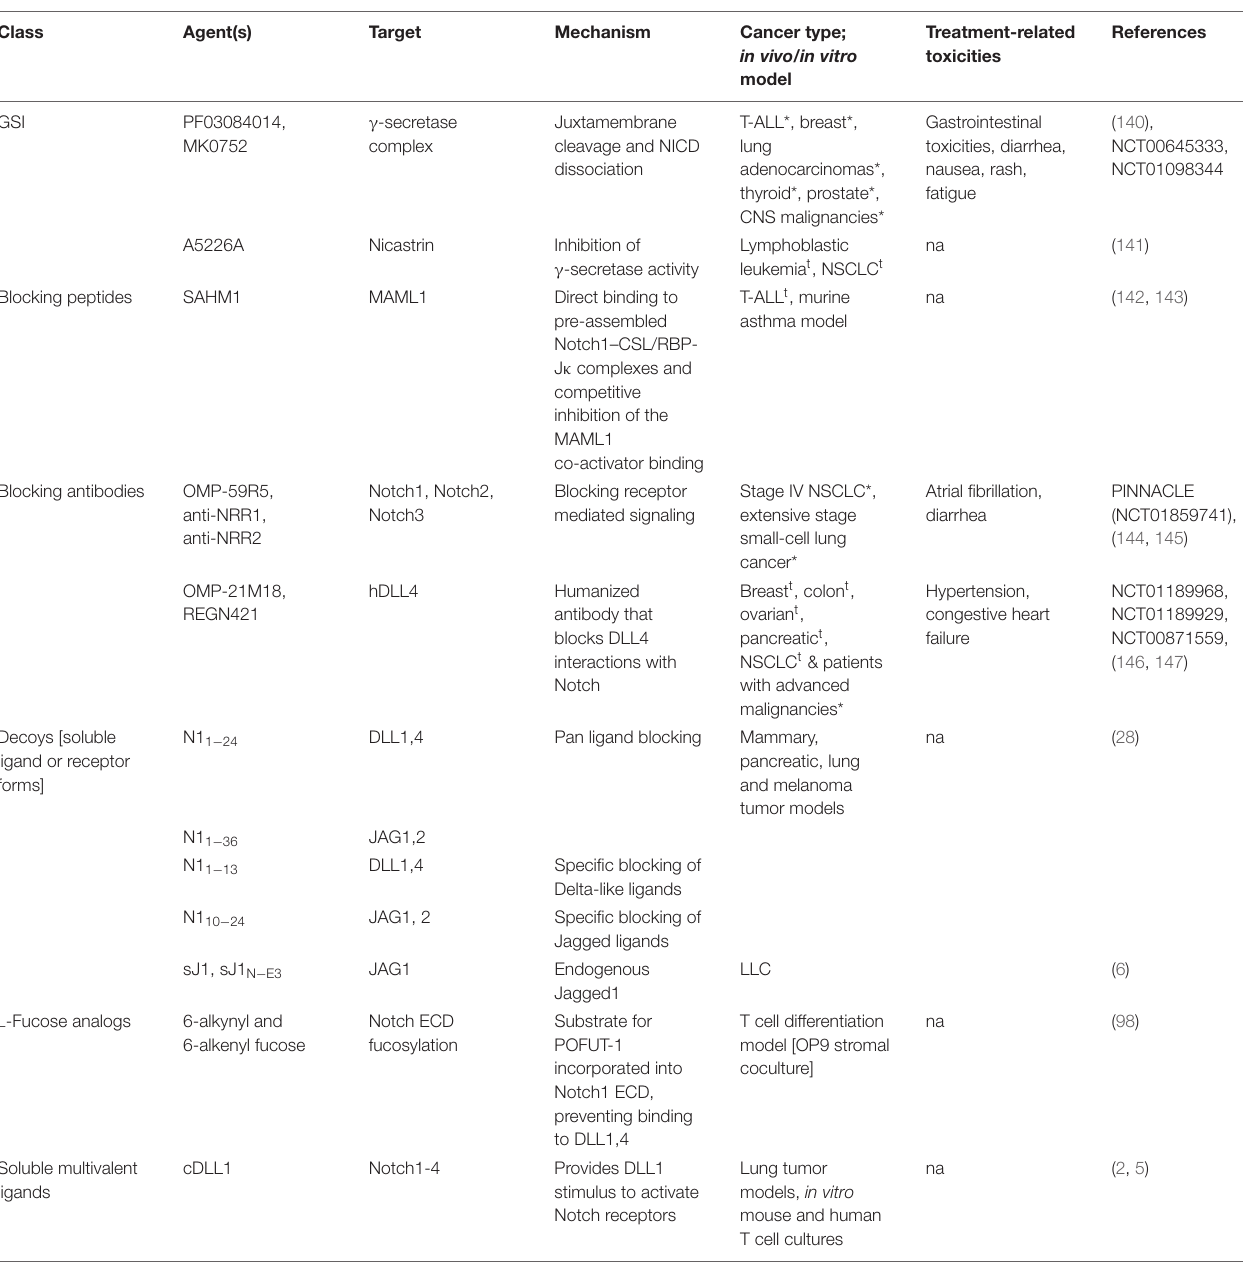
TABLE 1 | Strategies to target Notch